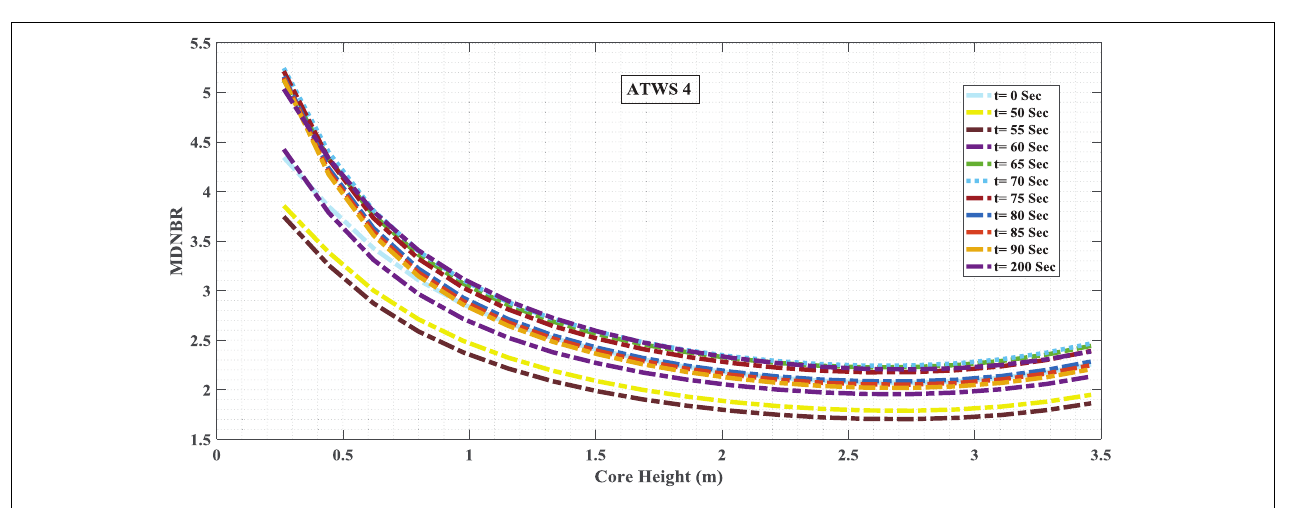
FIGURE 14 | MDNBR in core heights during ATWS 3.